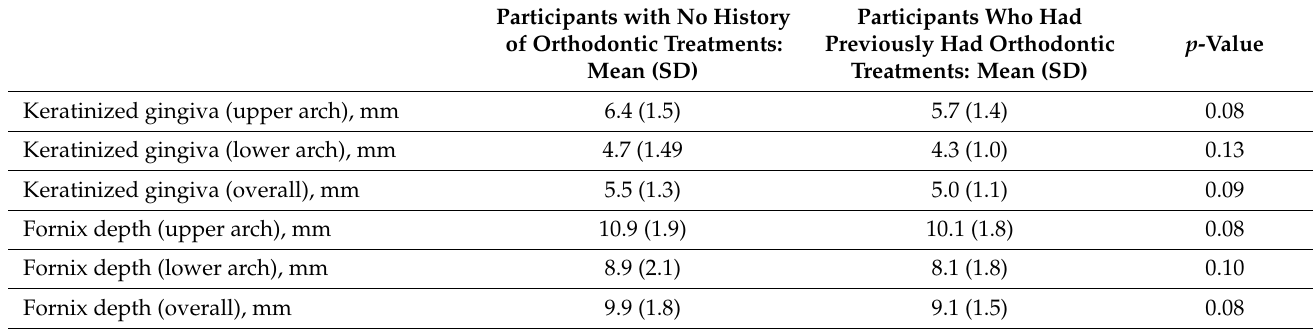
Table 4. Associations between anatomical parameters and orthodontic